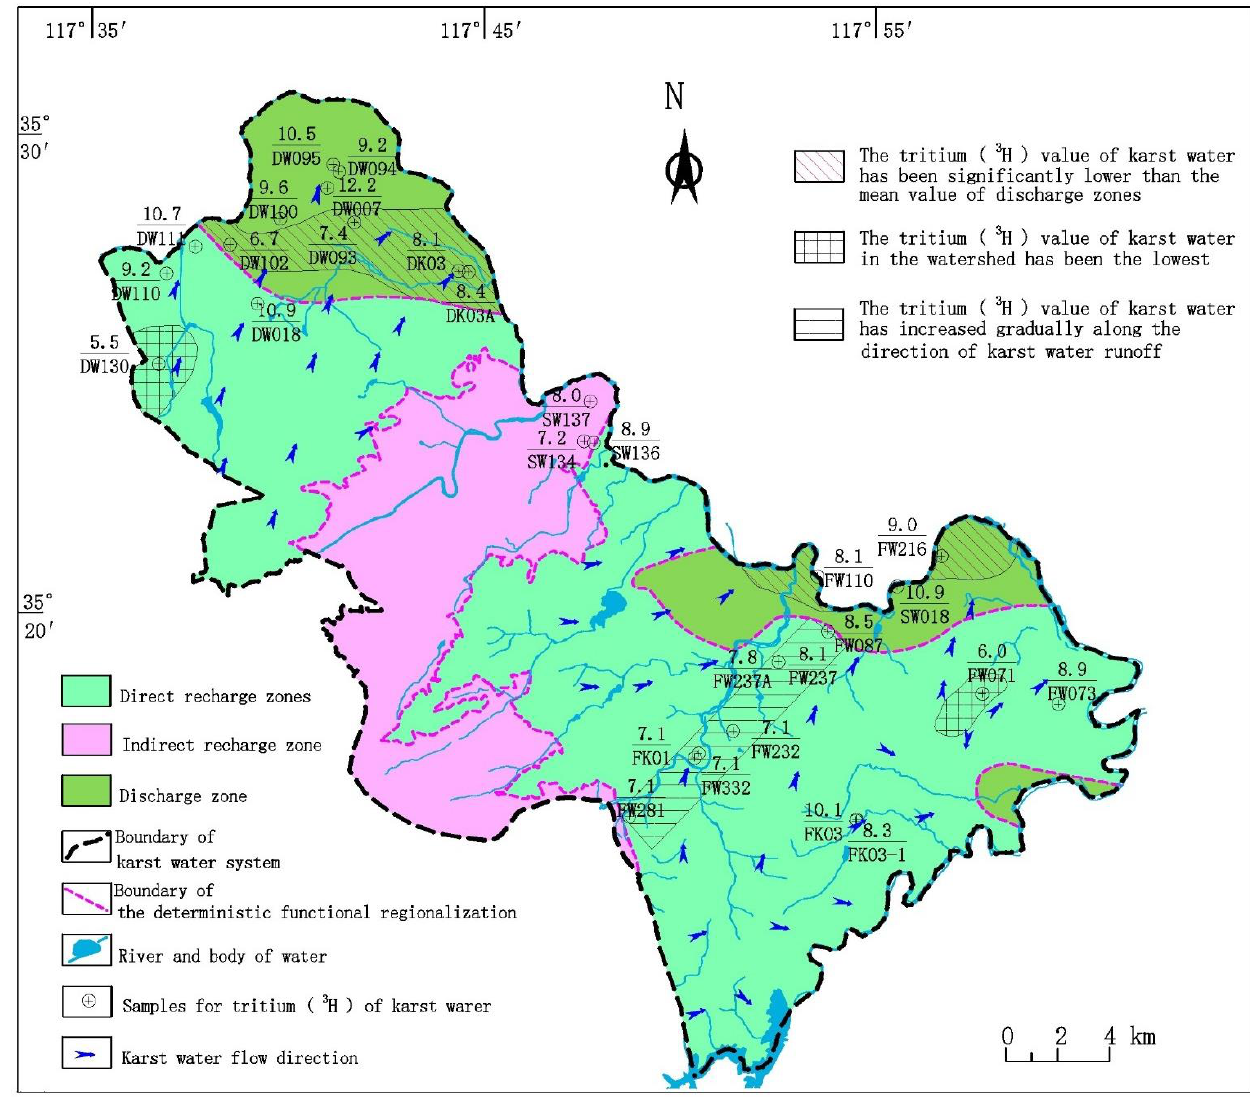
Figure 8. Distribution characteristics of the tritium ( 3 H) values of karst water.